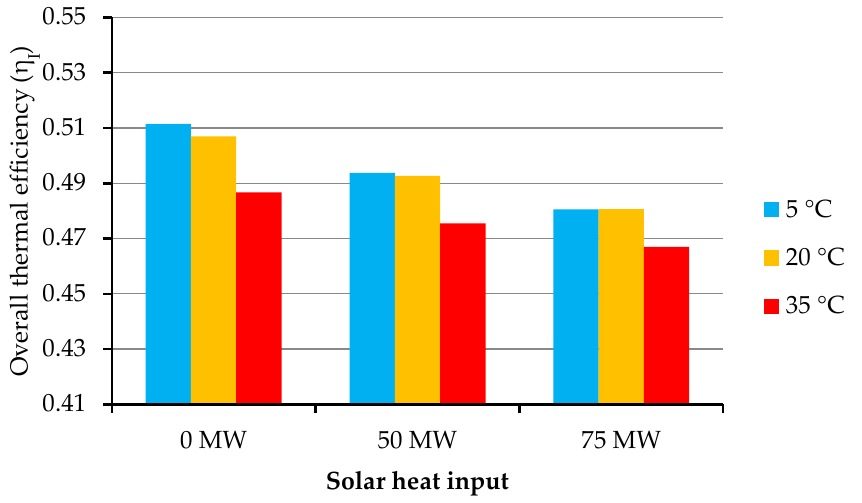
Figure 2. The overall thermal efficiency of the power plant at different ambient temperatures for different solar heat inputs.